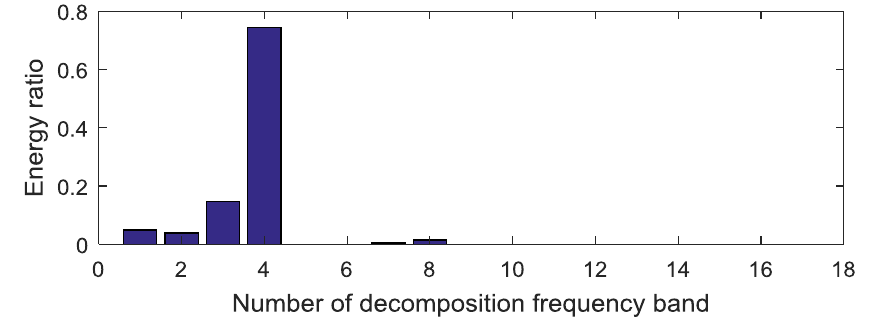
Figure 6. Energy distribution proportional histogram of the sun gear chipped.